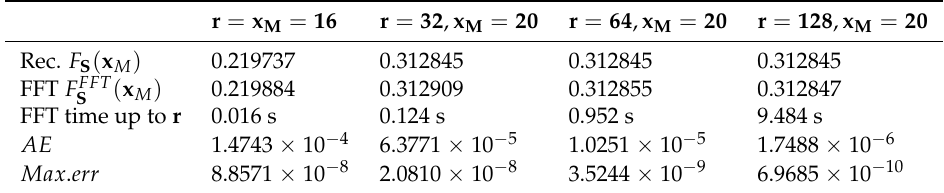
Table 1. Example 1: Comparing recursive and FFT methods for h = 1, θ = 7/ r and various r , x M . r = x M = 16